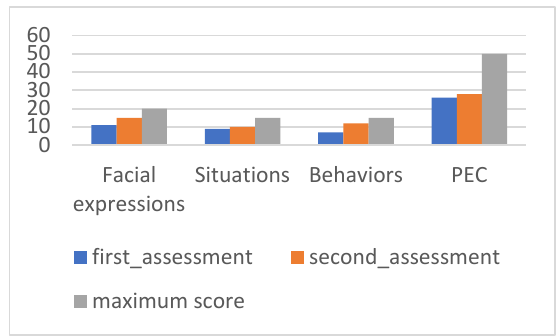
Figure 9. Nuno’s PEC results.